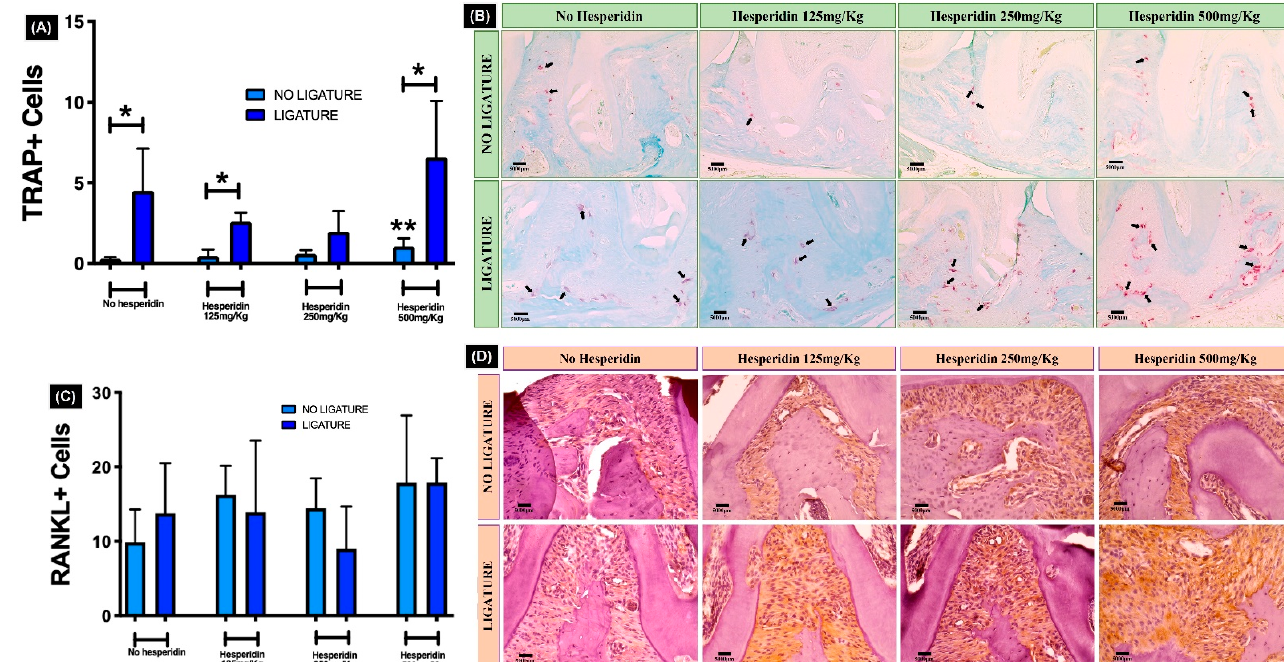
Figure 5. Quantification of osteoclasts in alveolar bone tissue. ( A ) Graph shows a significant increased number of TRAP+ cells in the bone tissue, generated by ligature placement. In ( B ), the black arrows indicate the multinucleated osteoclasts stained in pink (TRAP+ cells) on bone surface. * p < 0.05 comparing ligature and no-ligature groups; ** p < 0.05 compared to no-ligature and no-hesperidin group. The number of RANKL+ cells stained in brown ( D ) was not affected by ligature and/or hesperidin treatment ( C ). Photomicrographs—20× magnification.